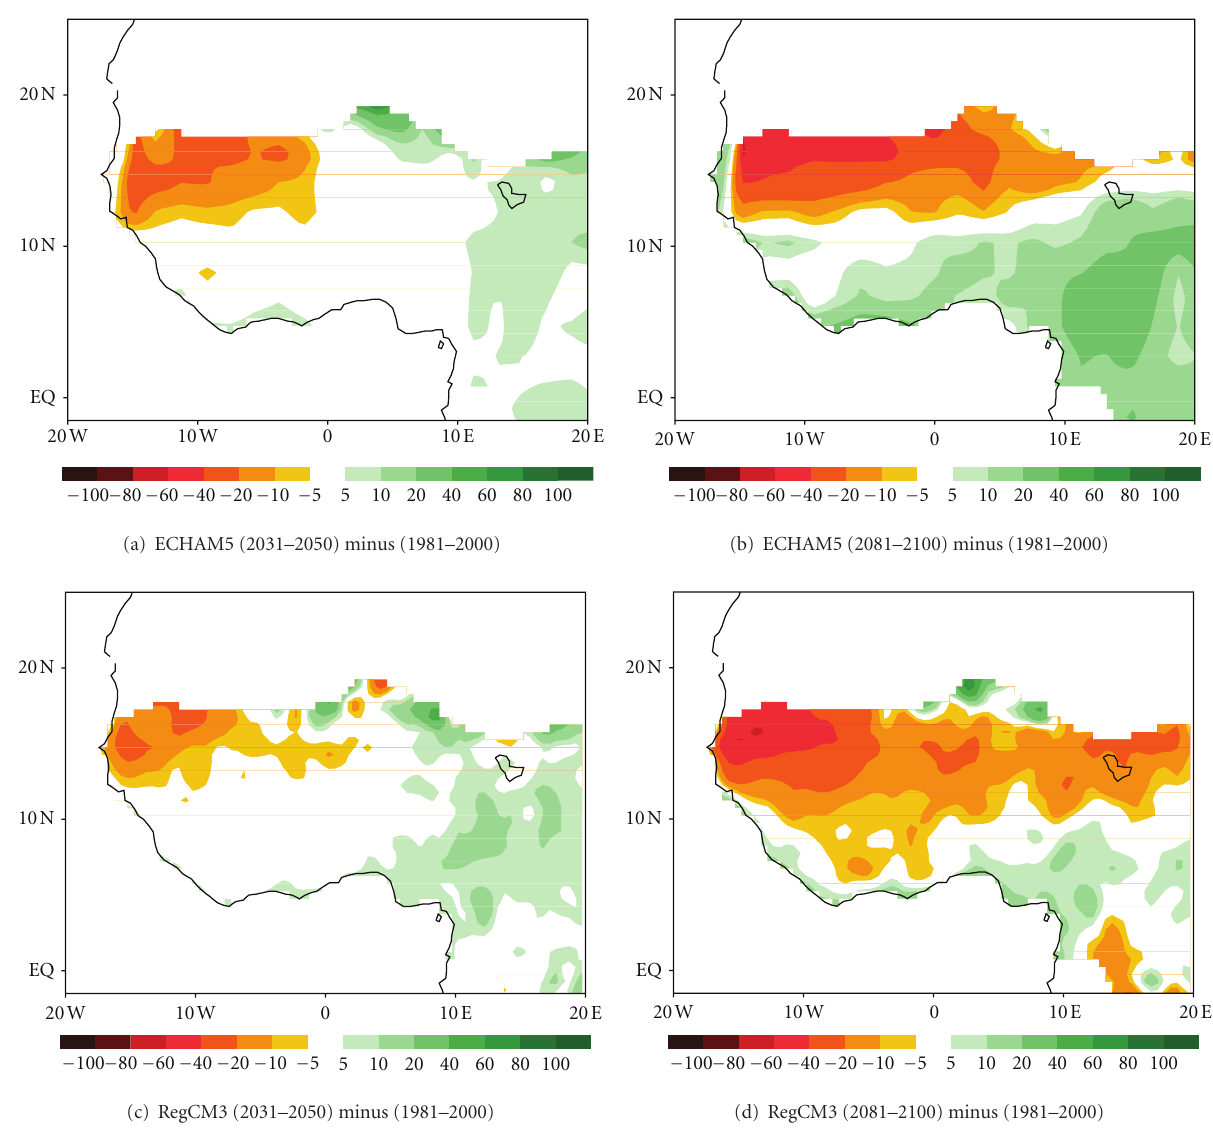
Figure 3: The same as Figure 2 but for